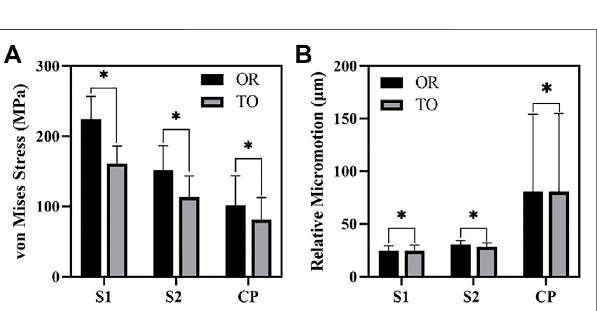
FIGURE 7 | The results of von Mises Stress and relative micromotion on S1, S2 and CP. (A) The results of average stress. (B) The results of average micromotion. S1, S2 represented the S1, S2 screw, and CP represented the connectingplate.ORandTOrepresentedoriginalgroupandtopological optimization group, respectively. * represented p <